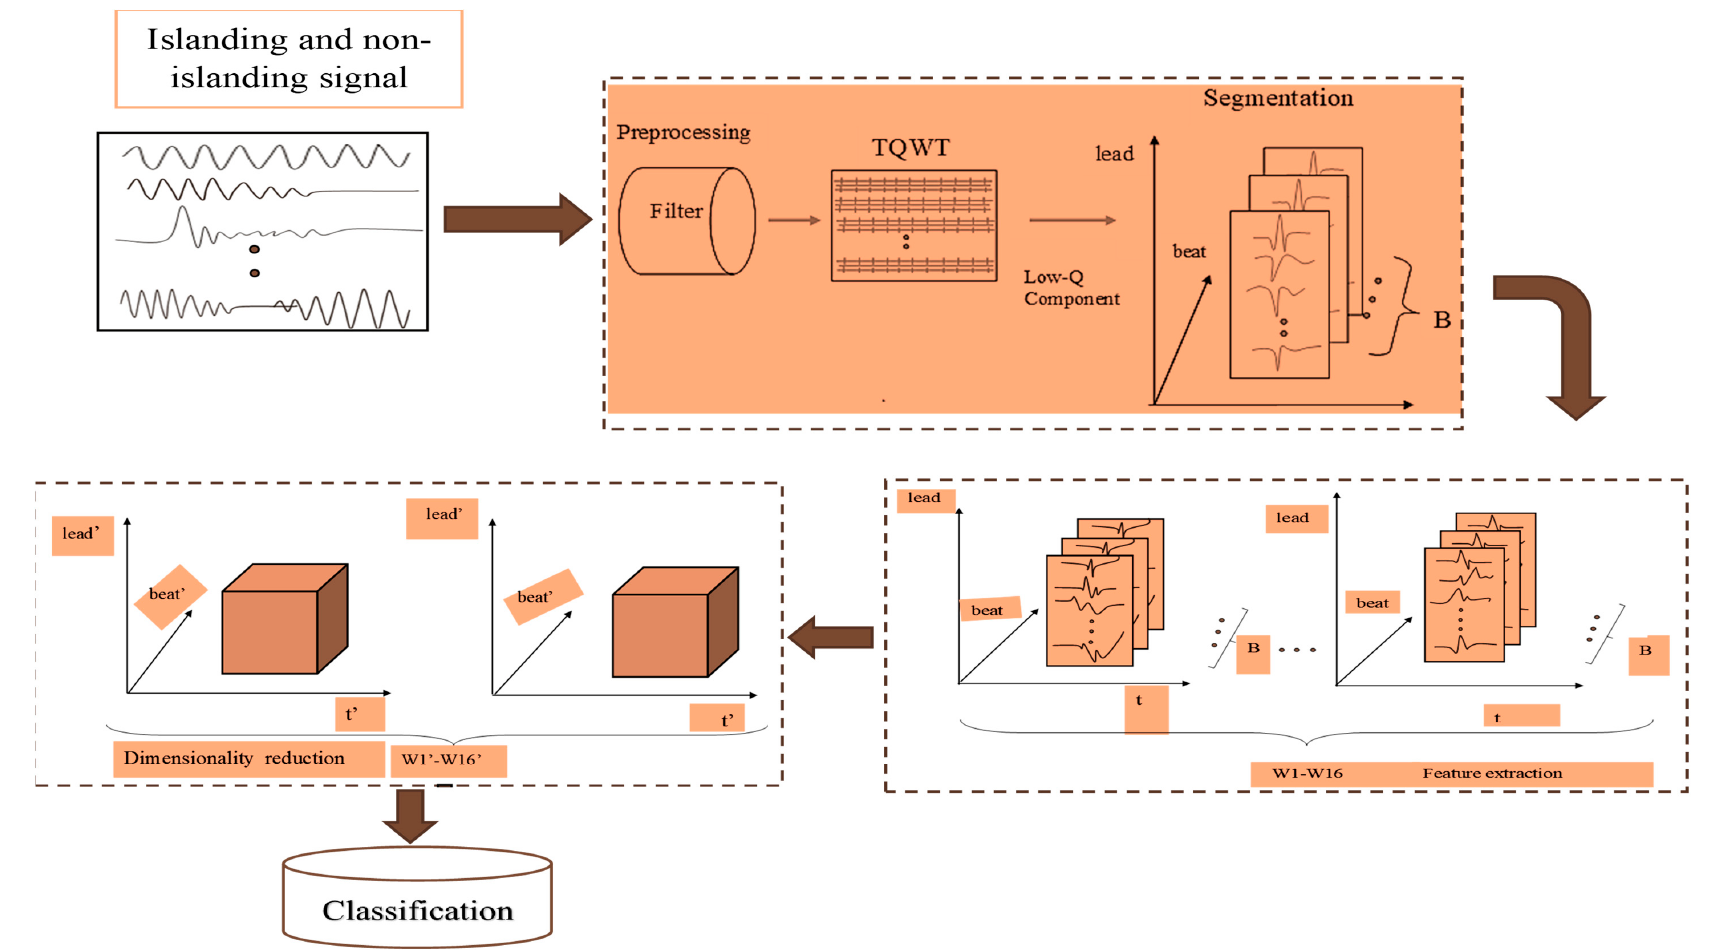
Figure 6. Block diagram representing the application of tunable Q-factor wavelet transform for islanding detection in photovoltaic based distributed power generation.